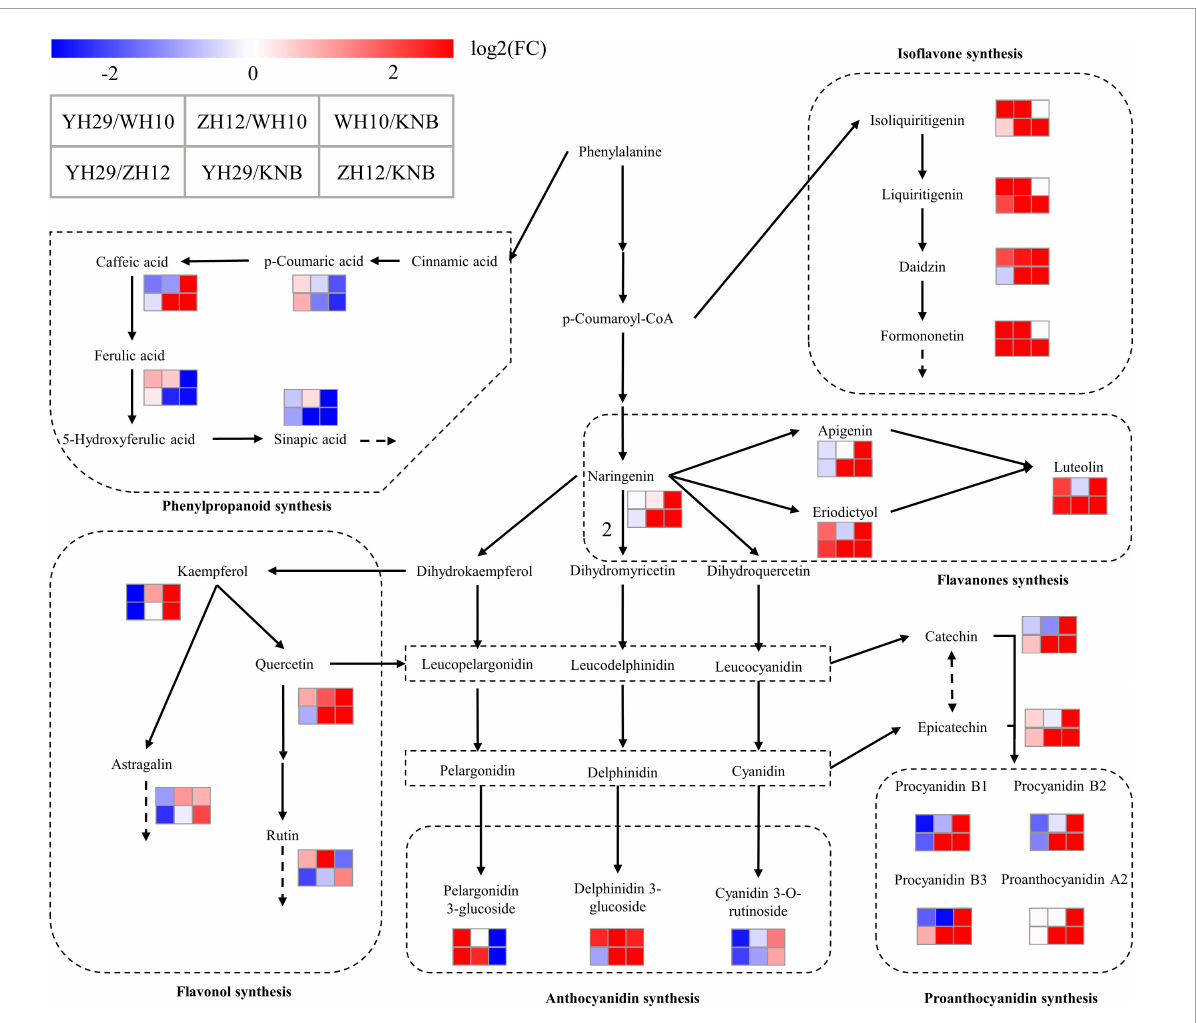
FIGURE7 Schematic diagram of the metabolic pathway and relative content of metabolites. (A) ZH12 and WH10; (B) WH10 and KNB. The absolute content is shown in the small histogram next to the compound using the average of all values. The metabolic pathway was modified based on the KEGG database